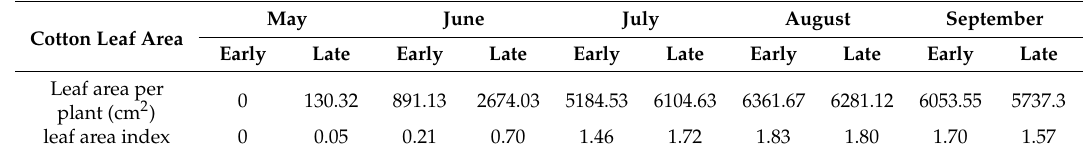
Table 5. Cotton leaf area